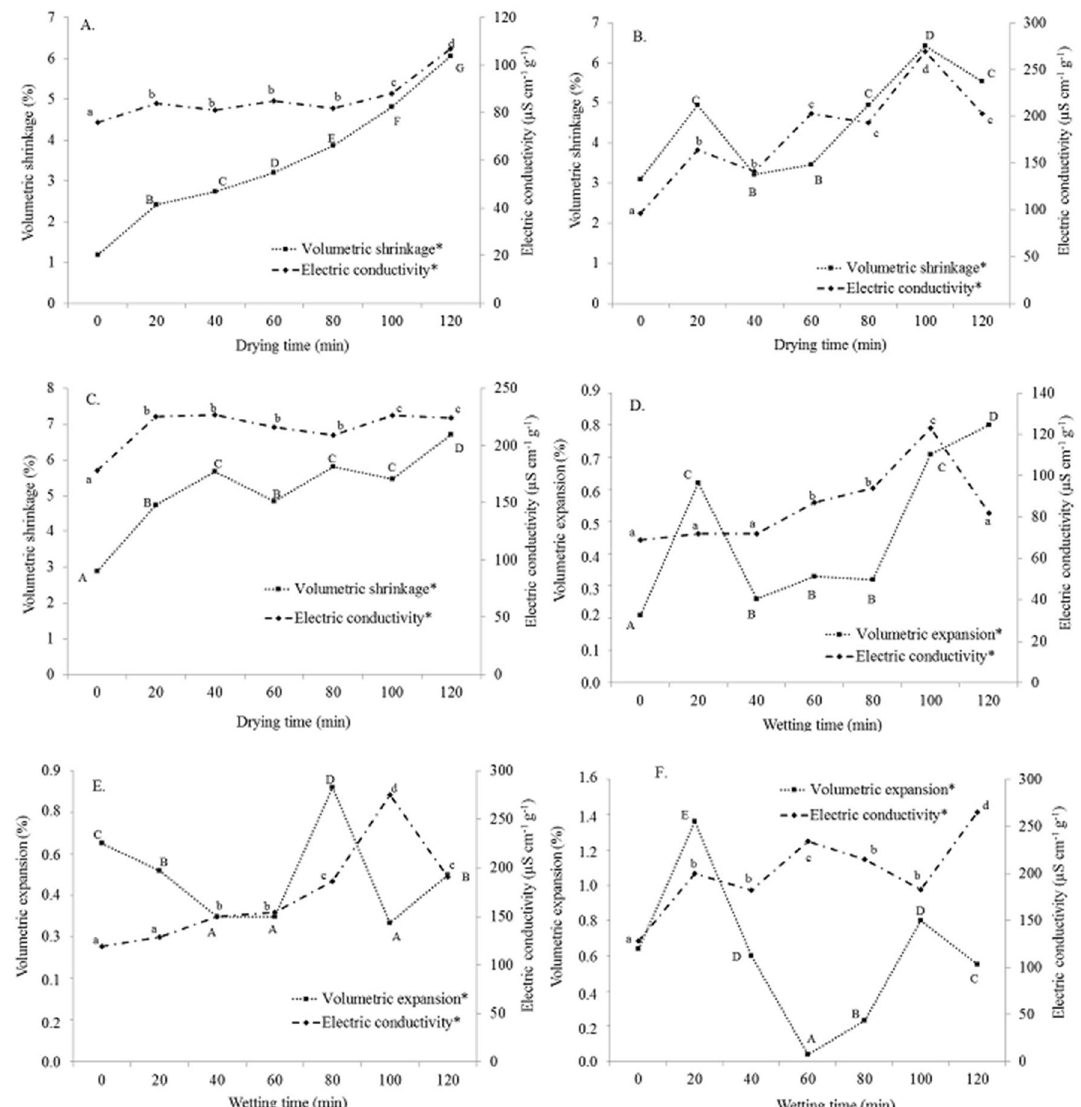
Figure 4. Volumetric shrinkage variation and expansion—electrical conductivity during the drying and wetting procedures: ( A , D ) 80, ( B , E ) 100, and ( C , F ) 120 °C. *Significant at a probability of 5% in the Tukey